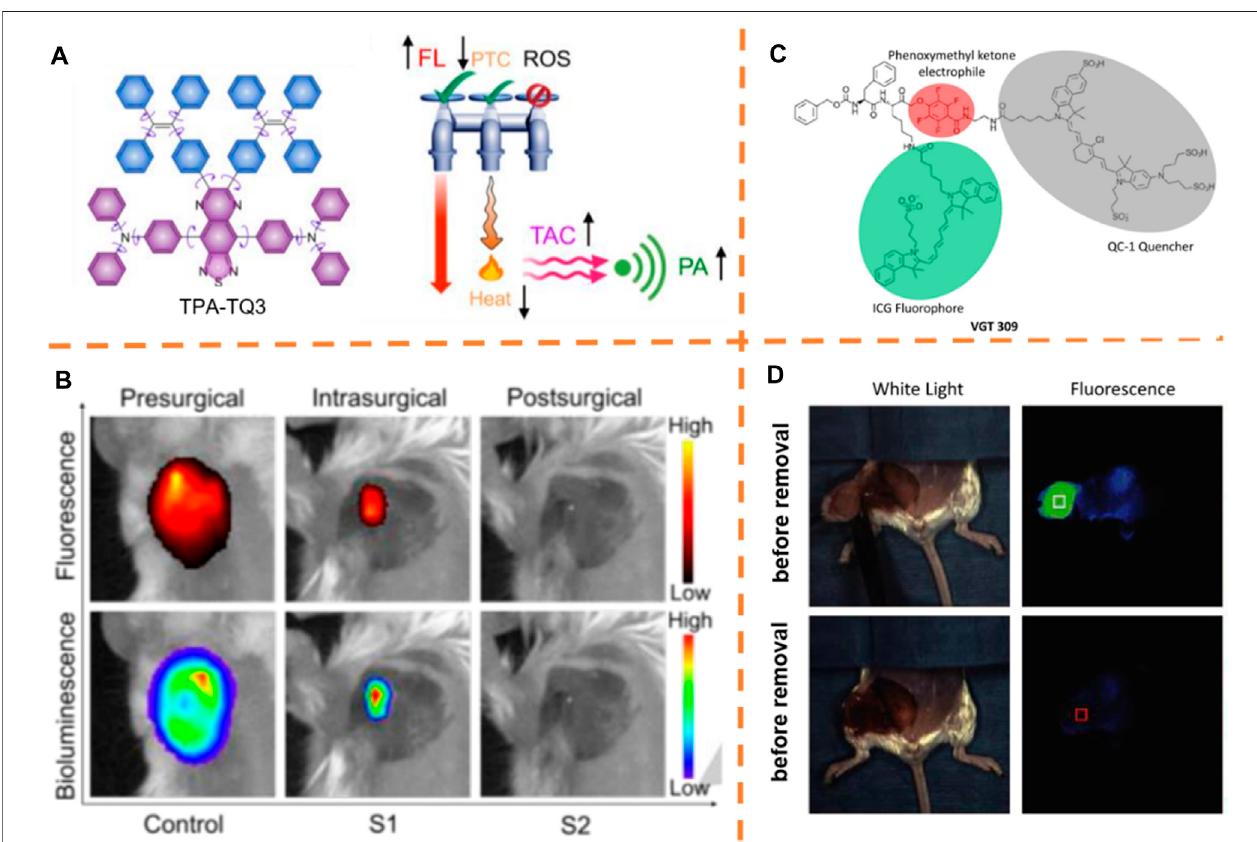
FIGURE 2 | (A) Chemical structure of TPA-TQ3. (B) Typical pre-, intra- and post-surgical fl uorescence/bioluminescence images of orthotopic 4T1 breast tumor. Adapted with content from Gao et al. (2021). (C) Chemical structure of VGT-309. (D) White light and fl uorescent images of the surgical area before and after tumor removal. Adapted with permission from Suurs et al.